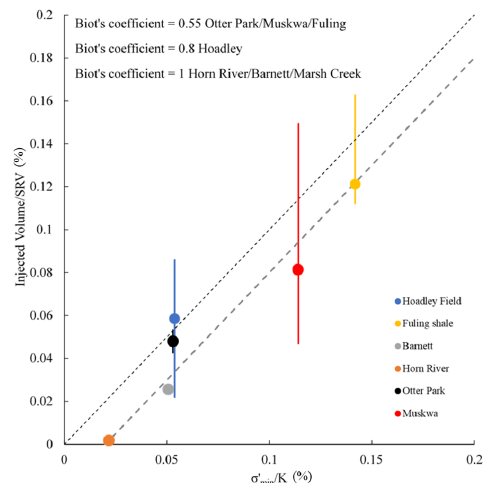
Figure 4. Volumetric strain comparison using the injected volume and minimum in-situ stress approaches. The plotted relation suggests that fracture propagates when strain due to injection equals the strain due to minimum in-situ